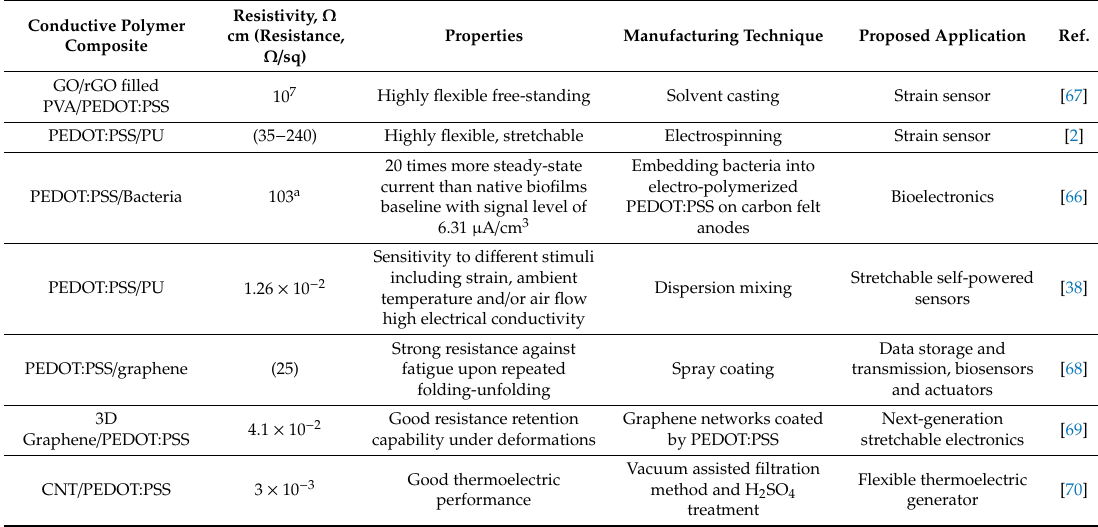
Table 3. Properties of common PEDOT:PSS based conductive polymer